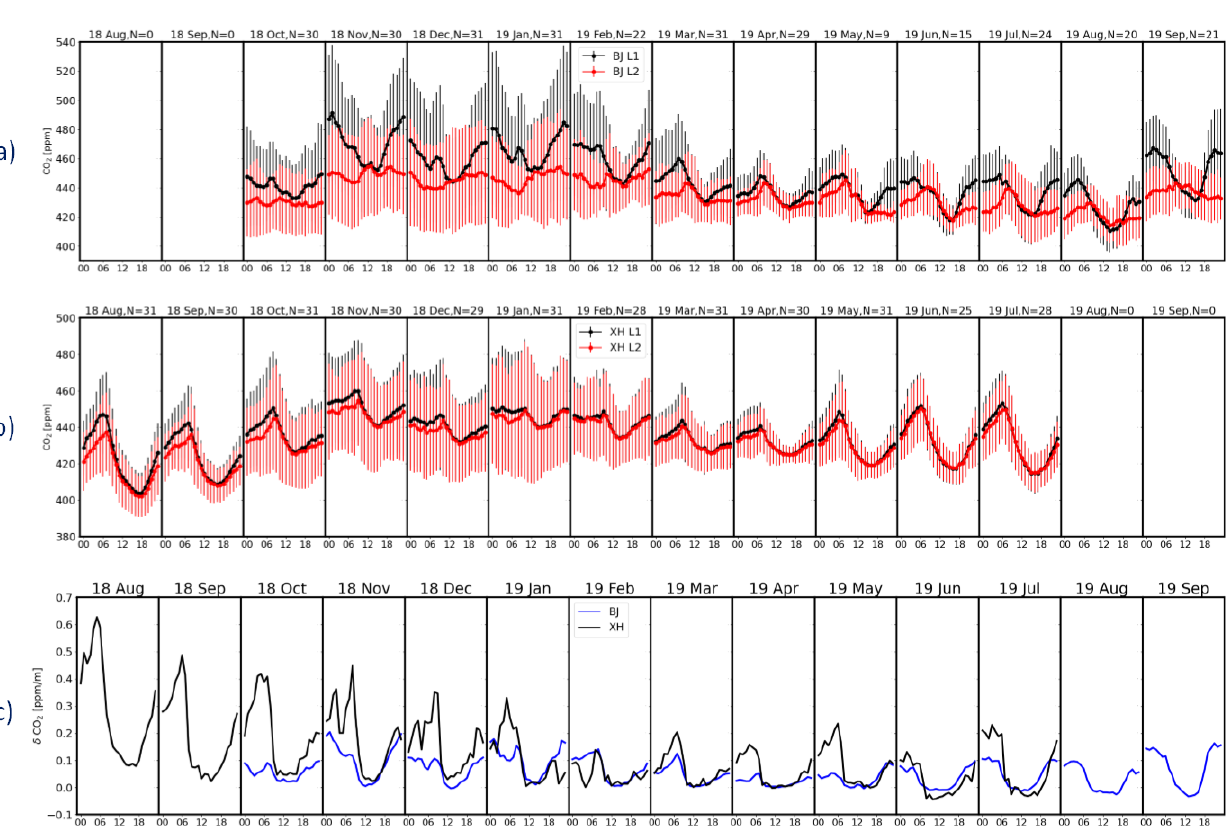
Figure 12. (a) The CO 2 measurements of BJ L1 and BJ L2 between October 2018 and September 2019. The error bars are the hourly standard deviations of CO 2 . (b) The CO 2 measurements of XH L1 and XH L2 between August 2018 and July 2019. (c) The hourly δ CO 2 [ppmm − 1 ] in each month at BJ and